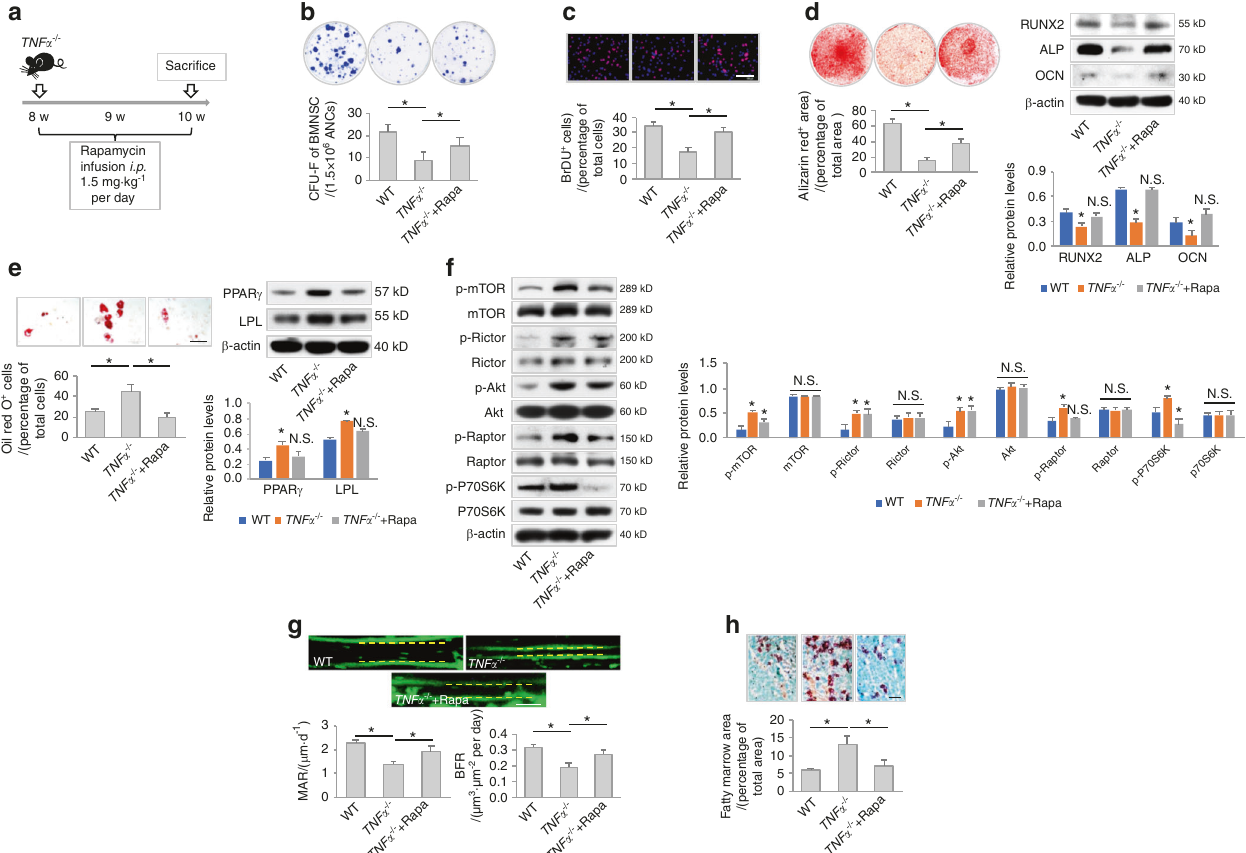
Fig. 4 Rapamycin infusion improves MSC function in TNF α − / − mice in vivo. a Schematic diagram showing the experimental design to investigate the effect of rapamycin treatment on TNF α − / − mice in vivo. b – e Functional analyses of MSCs according to CFU, BrdU labeling, and osteogenic and adipogenic differentiation ( N = 5). Scale bars = 100 μ m. f Western blot analyses of mTOR signaling ( N = 3). g Calcein labeling for bone formation analysis. N = 5. Scale bar = 50 μ m. h Oli red O staining for bone marrow adiposity. N = 5. Scale bar = 150 μ m. For quanti fi cation of Western blotting, a two-tailed Student ’ s t test was used for the comparison between the treatment and WT groups. * P < 0.05. Data represent the mean ±